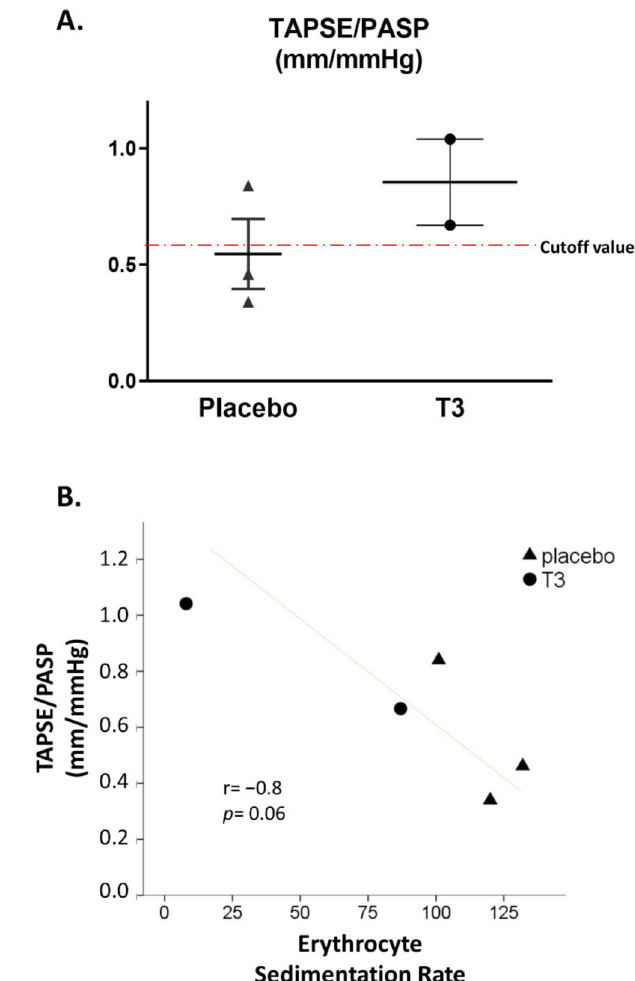
Figure 2. ( A ) Tricuspid annular plane systolic excursion (TAPSE) to systolic pulmonary artery pressure (PASP) ratio for placebo and T3-treated patients at 48 h in COVID-19 patients recruited in Thy-Support trial is shown. Please note that T3-treated patients are above the cut-off value of 0.57, which is reported to determine prognosis in these patients. ( B ) A strong inverse correlation seems to exist between erythrocyte sedimentation rate with TAPSE/PASP ratio at 48 h in COVID-19 patients recruited in Thy-Support trial. T3: